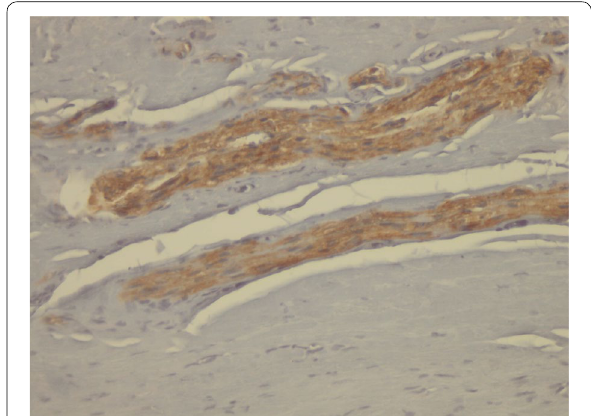
Fig. 4 High S100 immunoreactivity in large nerve bundles on the dorsal surface ( 400) ×